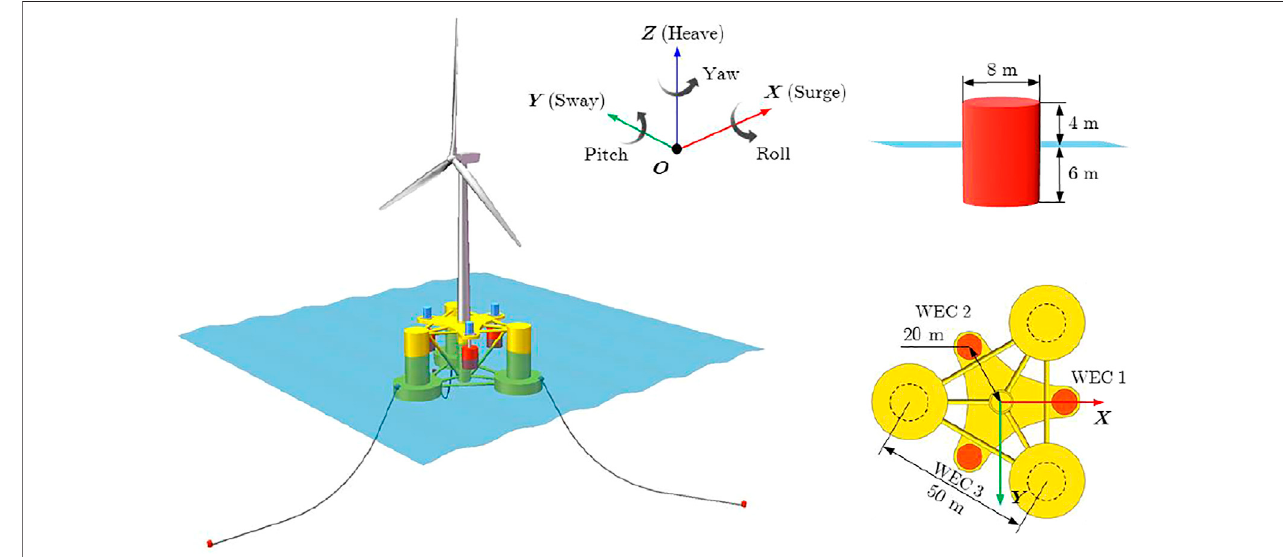
FIGURE 1 | Concept design of the hybrid wind-wave energy platform.